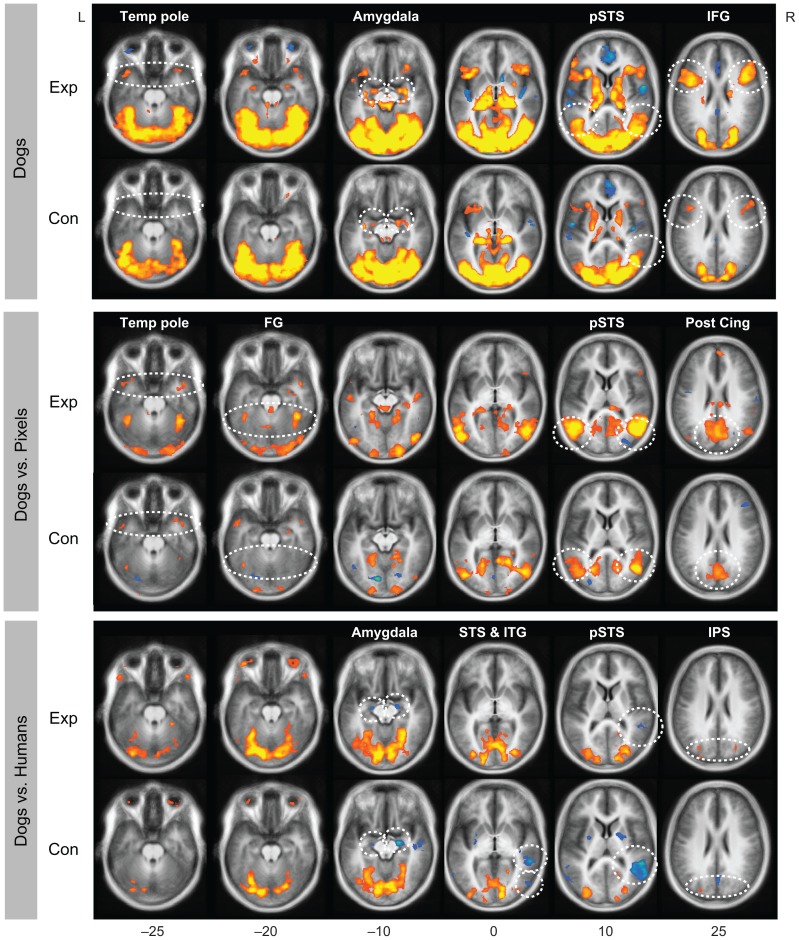
Brain activation of dog experts and control subjects in two-way statistical maps.Top panel: Dogs (Dog_toward+Dog_away). Middle panel: Activation to Dogs vs. Pixels. Bottom panel: Activation to Dogs vs. Humans. The FDR-corrected statistical maps (q<0.05) are overlaid on the anatomical MR image averaged across all subjects. Red-yellow: stronger activation in [first] vs. [second] stimulus category, blue-green: stronger activation in [second] vs. [first] category. Temp pole = temporal pole, pSTS = posterior superior temporal sulcus, IFG = inferior frontal gyrus, FG = fusiform gyrus, Post Cing = posterior cingulate, ITG = inferior temporal gyrus, IPS = intraparietal sulcus. Exp = experts, Con = controls.